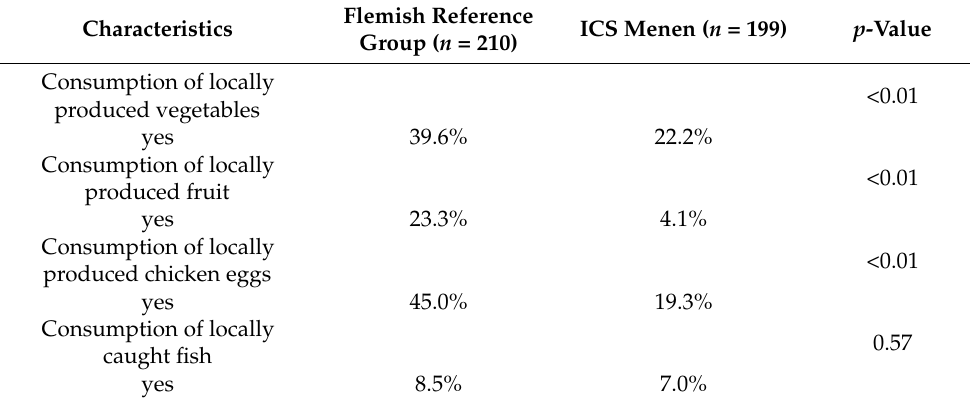
Table 3. Characteristics of the study population near the Menen ICS and of the reference group of FLEHS II (2010–2011).